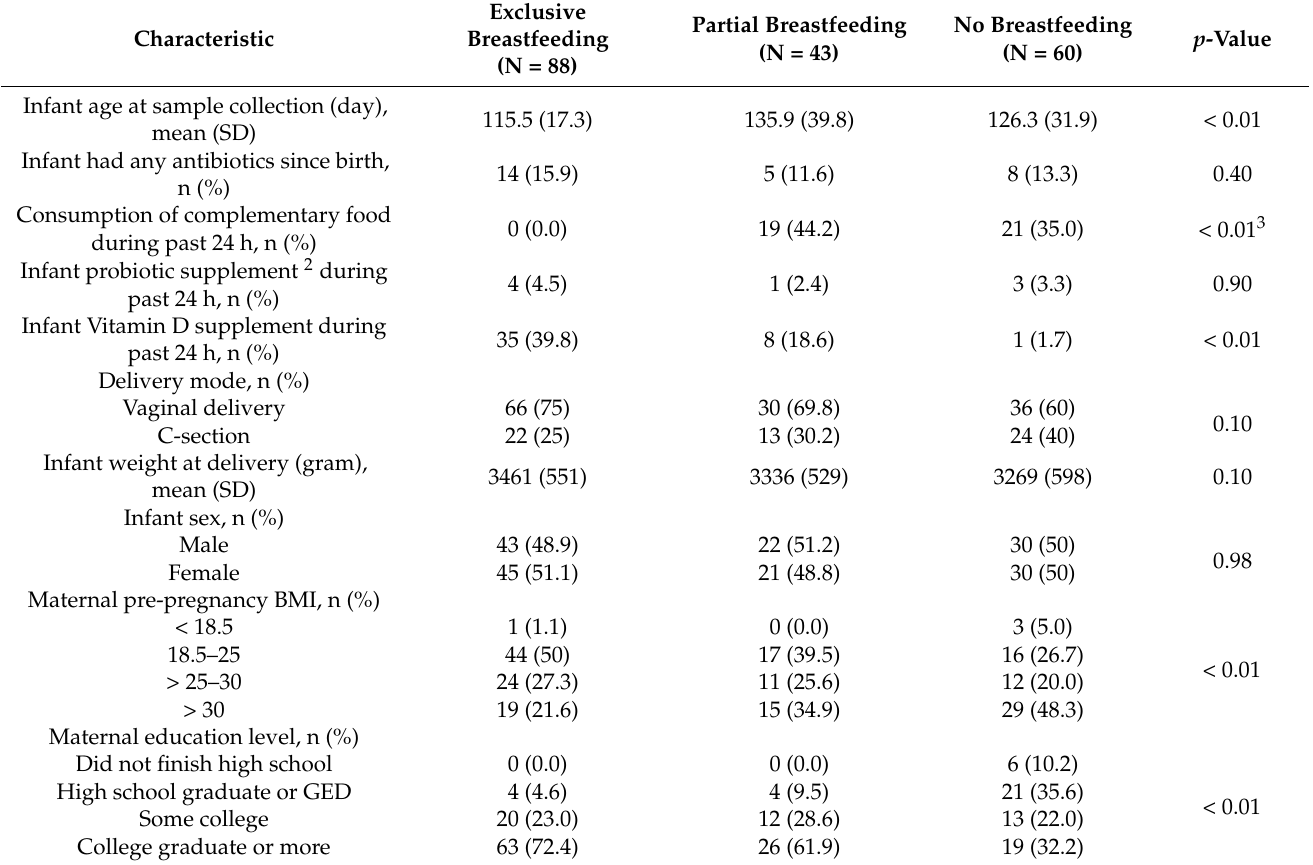
Table 1. Characteristics of the mothers and infants by breastfeeding status 1 .